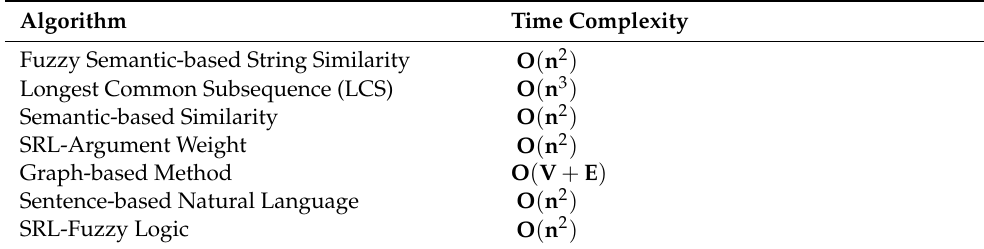
Table 7. Time complexity